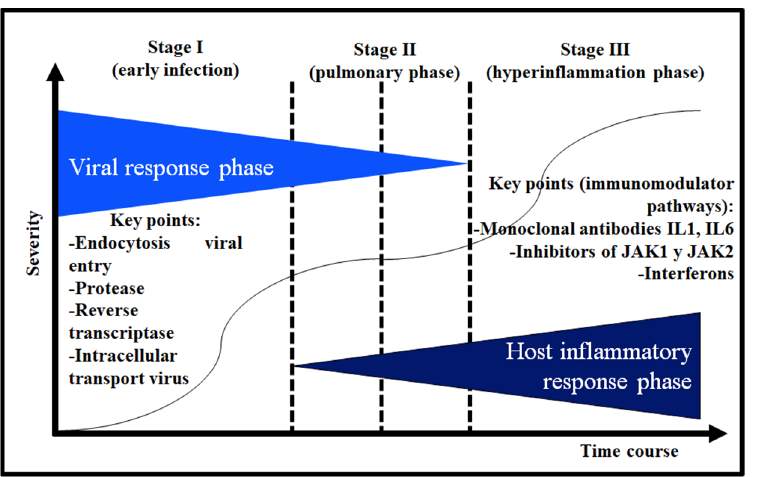
Figure 2. Differentiated phases of viral and proinflammatory response (interleukin 1: IL 1; interleukin 6: IL-6; Janus kinase: JAK).